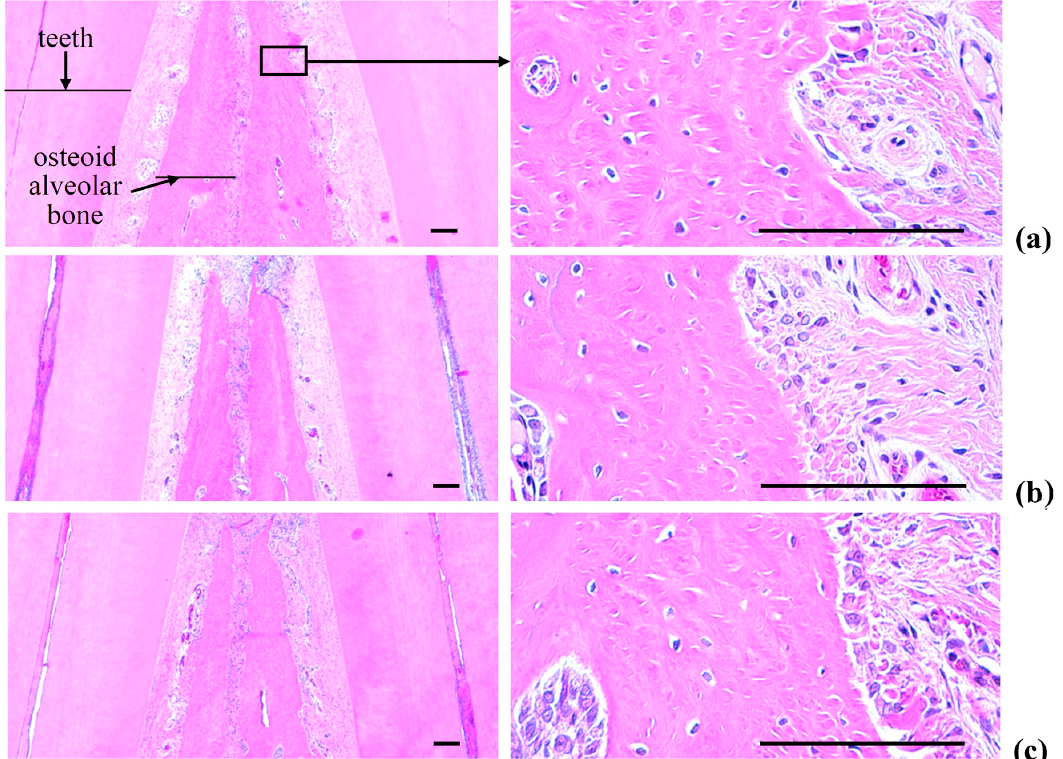
Figure 10. Cont. Figure 10. Cont.